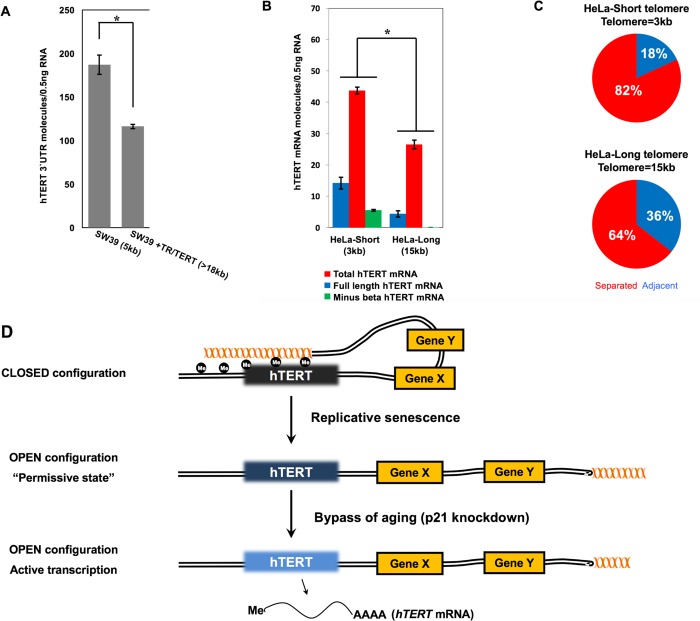
Telomere length affects expression of hTERT in telomerase-positive cancer cells.(A) SW39 cells were infected with viruses for ectopic expression of hTERT and hTR (hTERC). RNA was purified, and the 3ʹUTR was amplified to analyze endogenous level of hTERT mRNA. ddPCR was performed to assess relative expression levels. t test revealed a significant effect. *p < 0.005 (B) HeLa cells were cloned and infected with a floxable hTERT. After treatment of adeno-cre recombinase at different time points, HeLa clones with long and short telomeres at same number of population doublings in cell culture were established. The number of full-length, total, and minus beta hTERT mRNAs were assessed by amplifying exon7/8 junction, exon 15/16 junction, and the exon 6/9 junction respectively. Telomere lengths are determined by TRF and indicated under the graph. t test revealed a significant effect between splice variants. *p < 0.001 (C) Percentage of adjacent allele (A) pairs versus separated allele (S) pairs was determined by 3D-FISH in HeLa clones. HeLa clones with long and short telomeres at the same PD in culture were analyzed. (D) Simplified model of how TPE-OLD regulates hTERT expression in human cells during aging and cancer progression. See text for details. Data associated with this figure can be found in the supplemental data file (S1 Data).